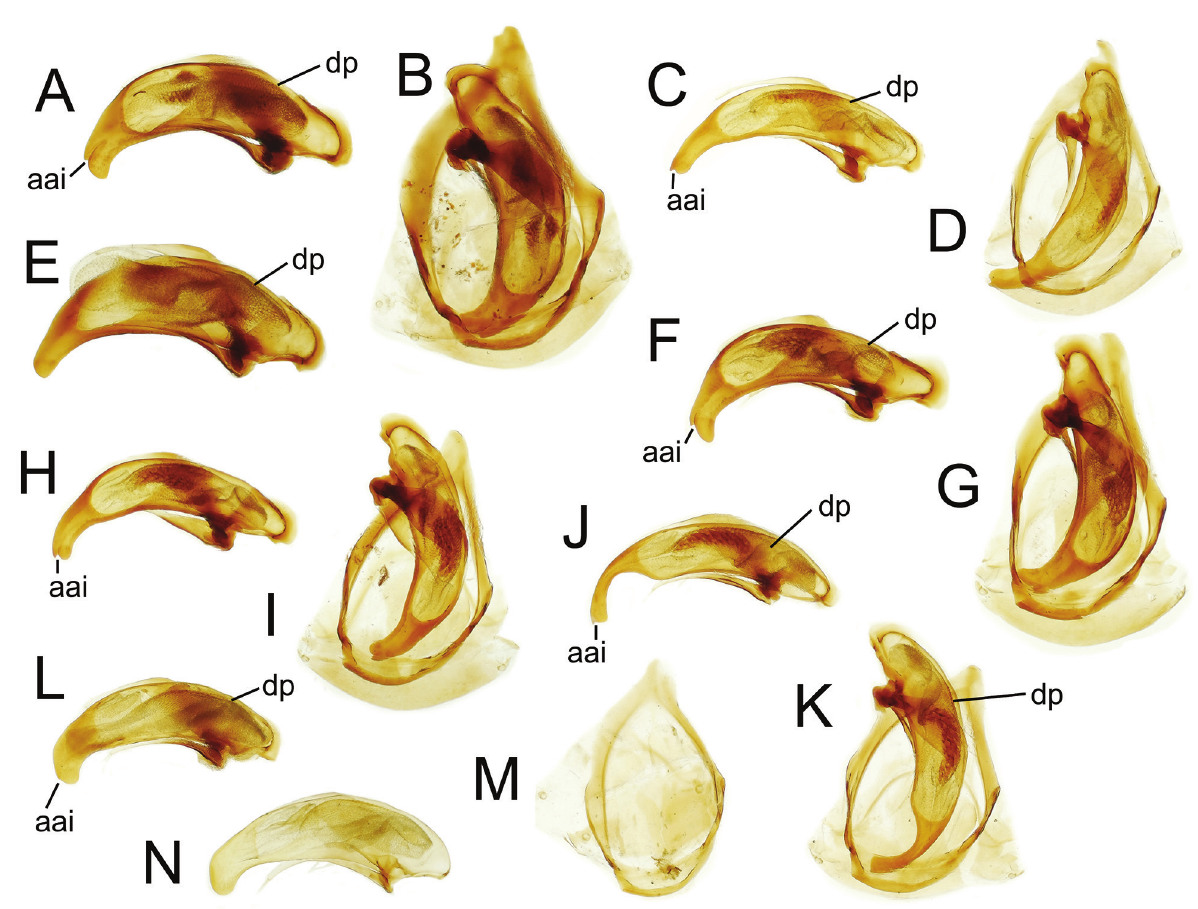
Figure 21. Male aedeagal median lobe and parameres, and ring sclerite–mediotergite plus antecostal margin, tergite IX–of Mecy- clothorax ( Phacothorax ) spp.: A–B , M. kanak , right view, dorsal view in situ (Mt. Humboldt, 630 m); C–D , M. kanak , right view, dorsal view in situ (Mt. Humboldt, 1400 m); E , M. kanak , form Q, right view (Mt. Humboldt, 1300 m); F–G , M. kanak , right view, dorsal view in situ (Mt. Dzumac); H–I , M. kanak , right view, dorsal view in situ (Rivière Bleue); J–K , M. kanak , right view, dorsal view in situ (Col de Yaté); L–N , M. picdupinsensis , right views, dorsal view of ring sclerite. See Table 2 for abbreviations.